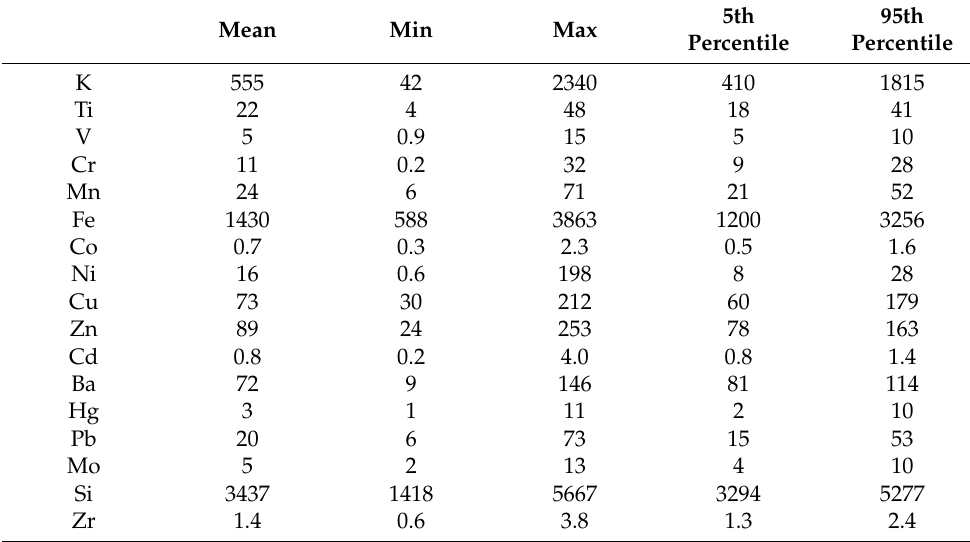
Table 3. Concentrations of mean, minimum, maximum, 5th percentile, 95th percentile of the analytes determined, expressed in ng m − 3 , for Consolata site.